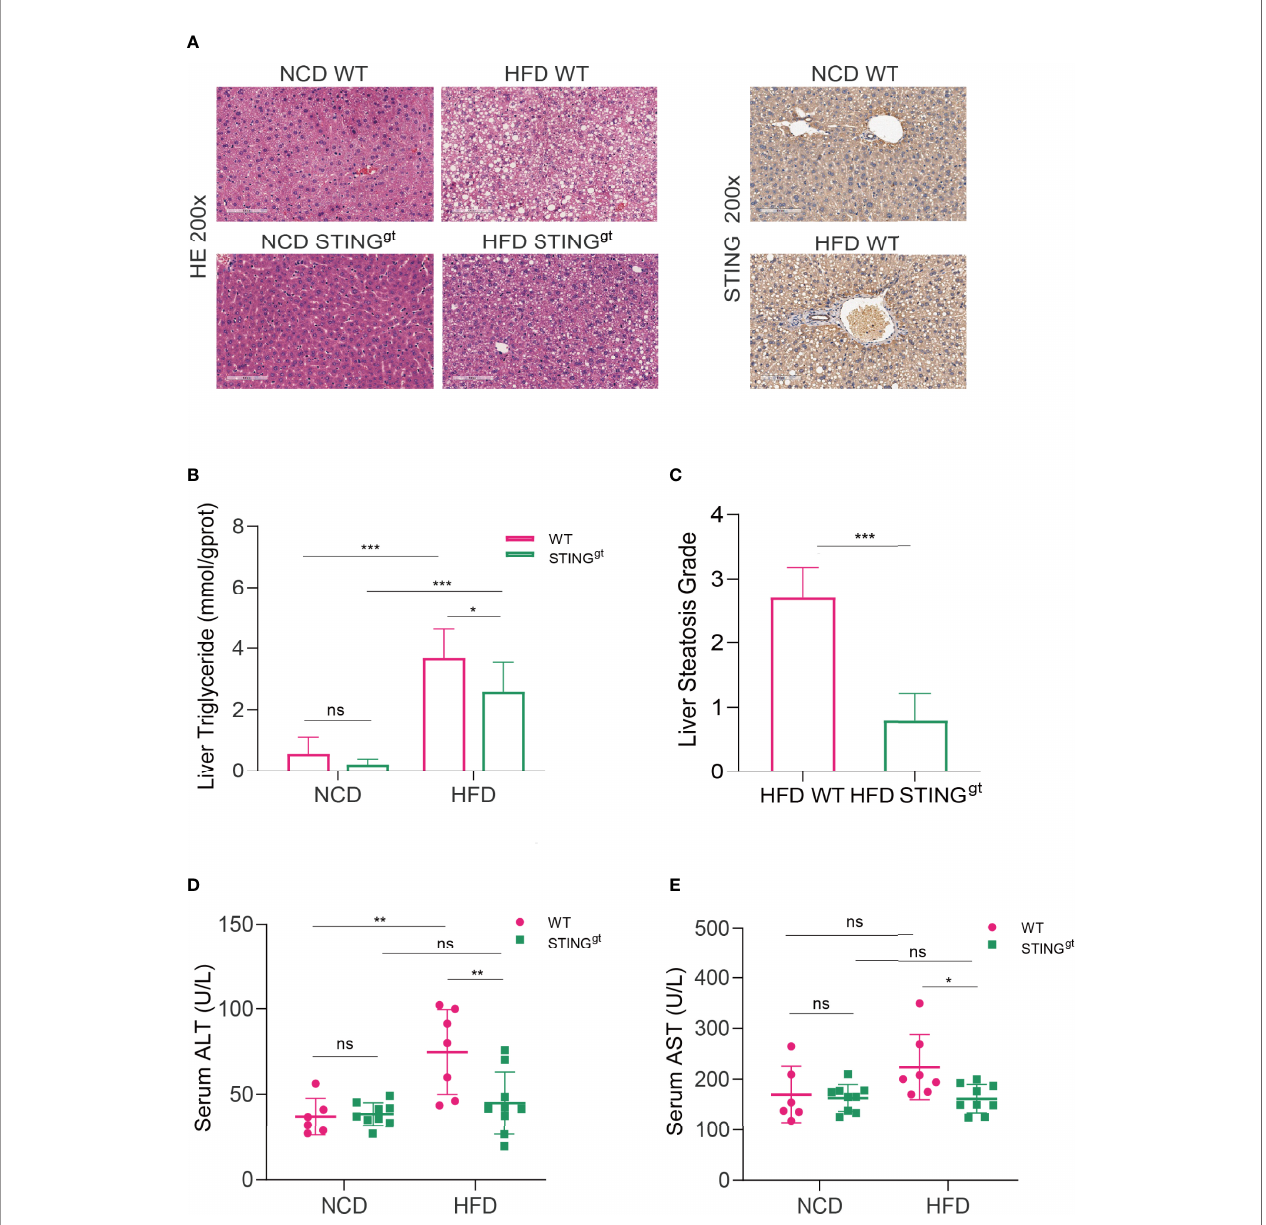
FIGURE 2 | STING de fi ciency alleviates HFD-induced steatohepatitis and liver injury. The liver and blood of mice were collected at 12 weeks. (A) Representative images of liver sections stained with HE and immunohistochemistry of STING. (B, C) Liver triglyceride content and hepatic steatosis scores were determined. (D, E) Serum levels of ALT and AST were measured. ns, no signi fi cance; ALT, alanine aminotransferase; AST, aspartate aminotransferase. Data are expressed as mean ± SD, n = 6 – 8 per group. *p < 0.05, **p < 0.01, ***p < 0.001 (unpaired t -test or